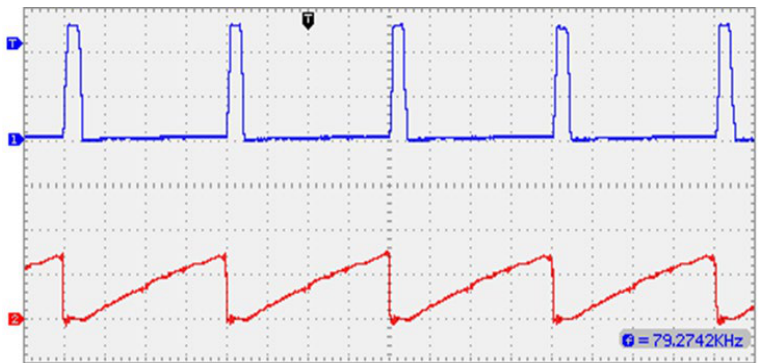
Figure 11. Voltage ( top ) and current ( bottom ) waveforms of switch M 1 (vertical scale 150 V/div or 8 A/div).